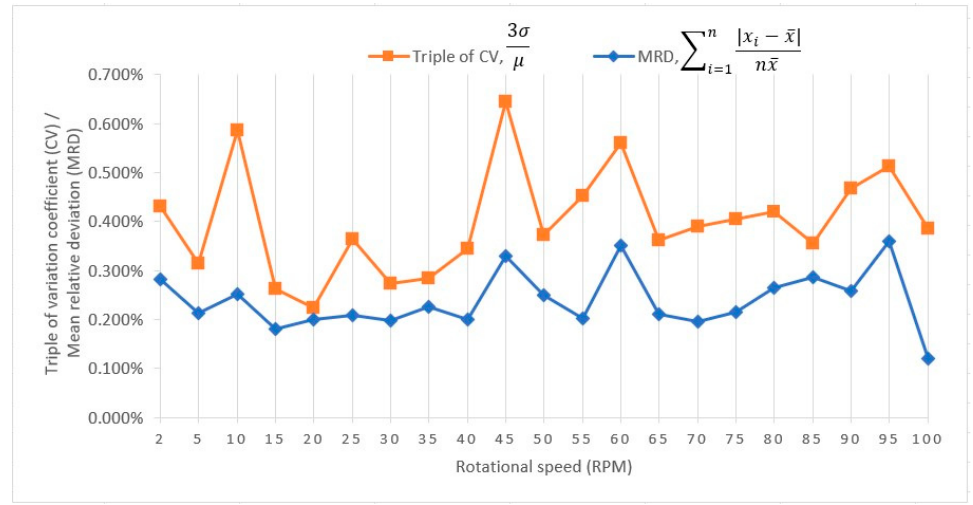
Figure 12. Frequency measuring results based on Hall effect gear tooth sensor.